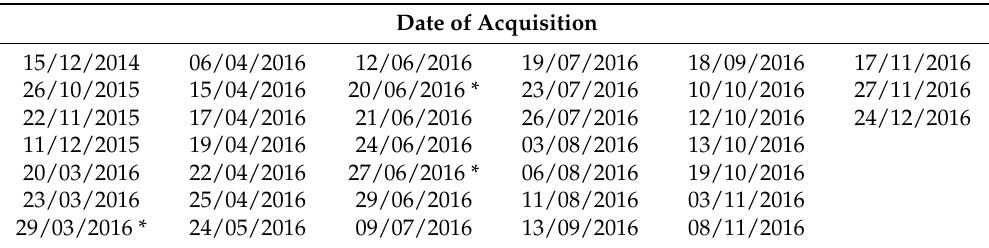
Very high resolution (VHR) optical satellite data (© 2018 DigitalGlobe; * © 2018 CNES/Airbus) accessed through Google Earth covering the UNESCO WHS of Aleppo, Syria and referred to in Section